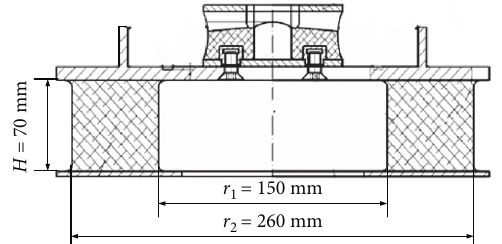
Figure 3: Rubber pad of a Chinese standard EMU bogie.